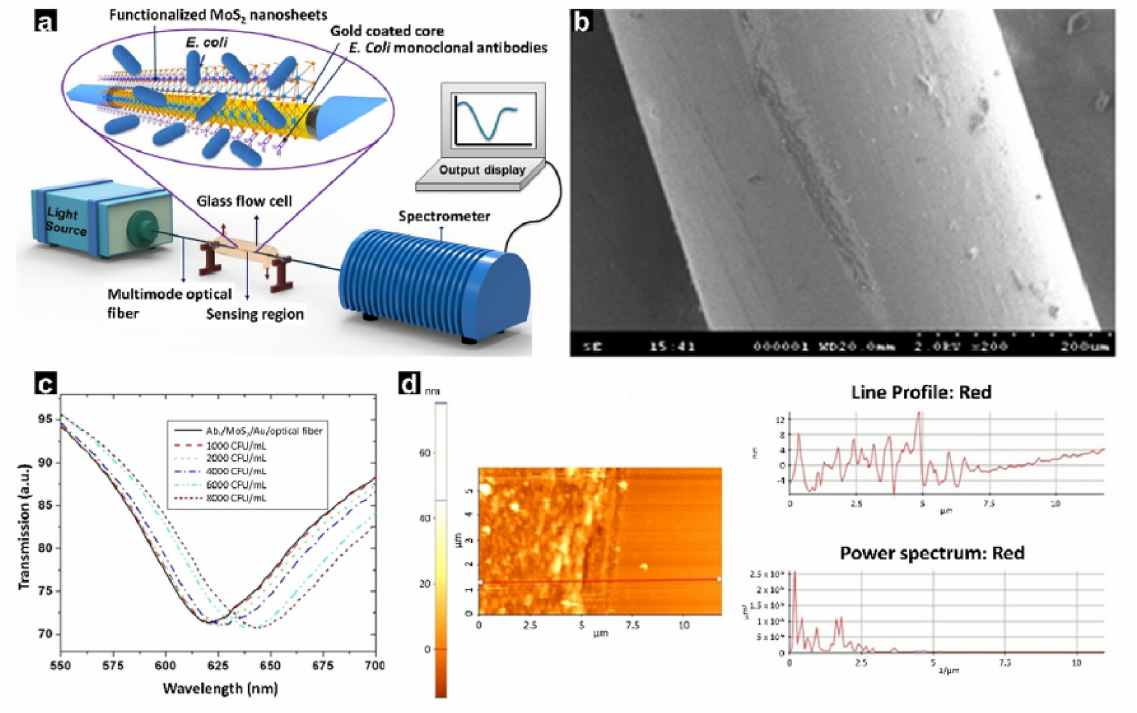
Figure 6. ( a ) Schematic illustration of an experimental setup to test sensors. ( b ) Field emission scanning electron microscope (FESEM) image of the fabricated optic fibre surface. ( c ) Transmission spectra plot indicating the limit of detection. ( d ) Atomic force microscope image analysis of the fabricated optic fibre surface. With permission from [91], Copyright 2018,